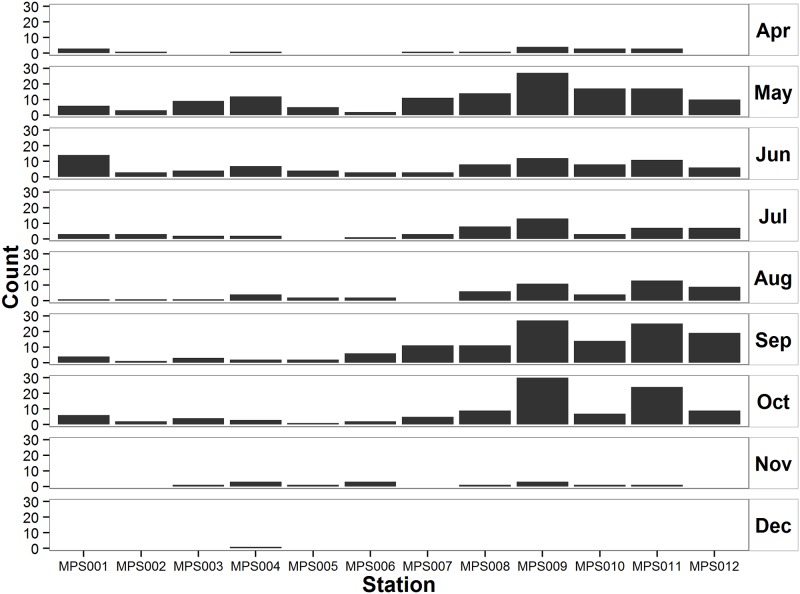
Sturgeon day distribution for acoustically tagged Atlantic sturgeon recorded on the Ocean Tracking Network Minas Passage Line, Minas Passage, Nova Scotia, Canada, totals for years 2010–2014.